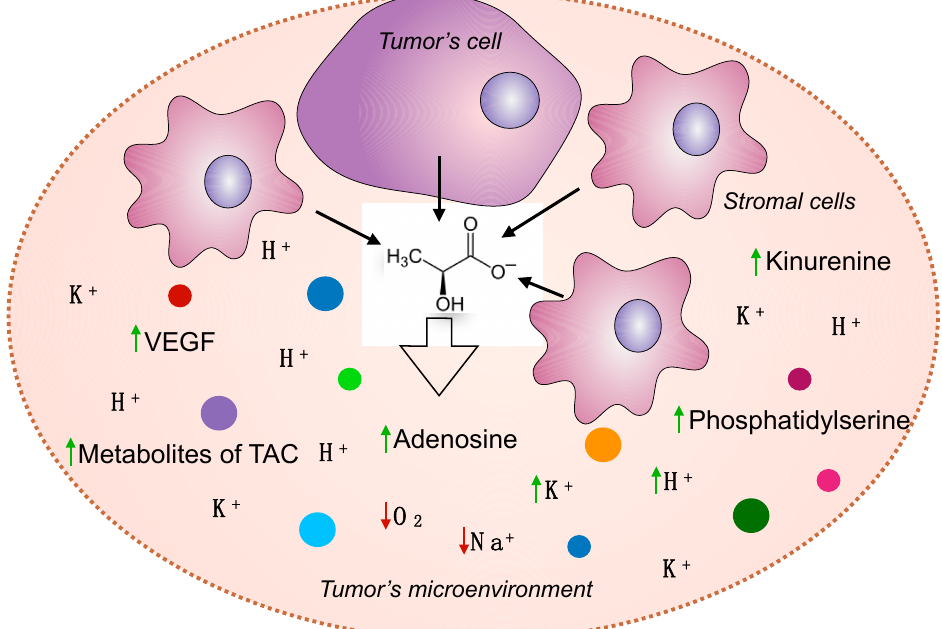
Figure 3. Metabolic reprogramming of the tumor microenvironment due to the Warburg effect. Increased lactate concentrations in the TME promote its acidification and the accumulation of different metabolites, whereas the concentrations of oxygen and sodium ions decrease.